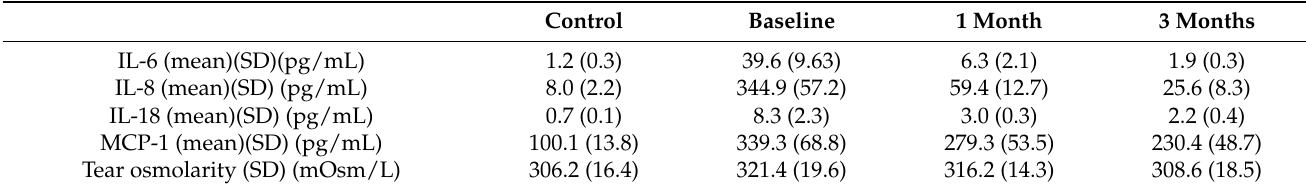
Table 3. Comparison of Tear Fluid Inflammatory Mediators in Patients